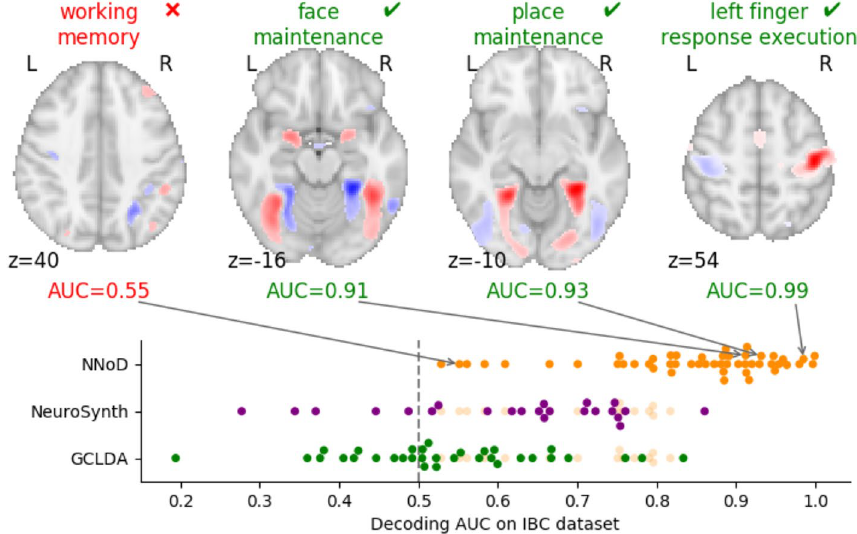
Figure 3. Decoding exactly-matched labels. We evaluated the AUC of the NNoD model on 37 labels matched in the IBC collection, after training it to decode 96 labels across collections. On the top, we show decoding maps for some example terms. Terms that are well decoded such as place maintenance have meaningful maps, whereas terms such as working memory whose neural correlates are poorly captured get low AUC scores. As the decoding maps do not have a meaningful scale, we threshold them arbitrarily at the 95th percentile for visualization. Using pre-trained GCLDA and NeuroSynth models, we compared NNoD results for the labels that also appear in the vocabulary recognized by these models (NNoD AUCs for terms in the vocabulary intersections are shown in light orange). Detailed scores for each label are represented in Fig. 4, showing that NNoD outperforms other methods for most